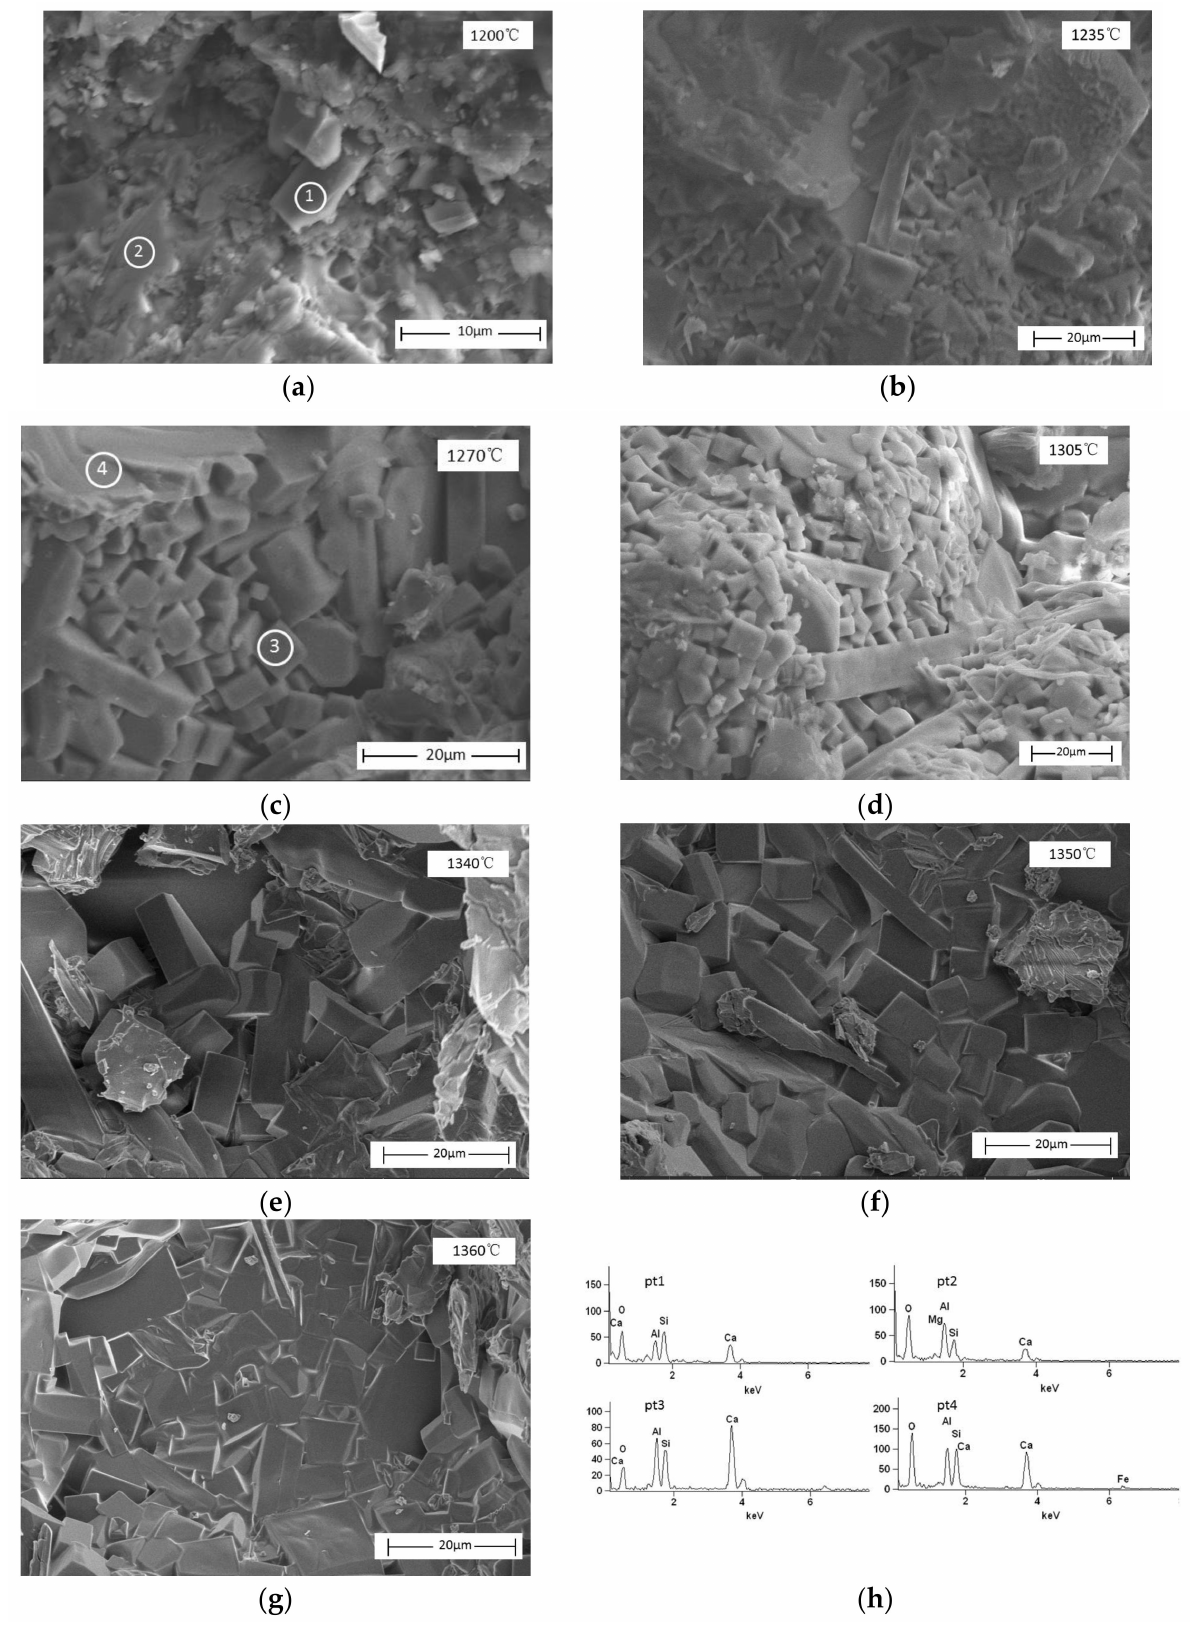
Figure 6. SEM observation of steel slag added with Al 2 O 3 –SiO 2 system at different sintering temperatures ( a – g ) and the EDS spectrum of point 1 to 4 ( h ) in ( a , c